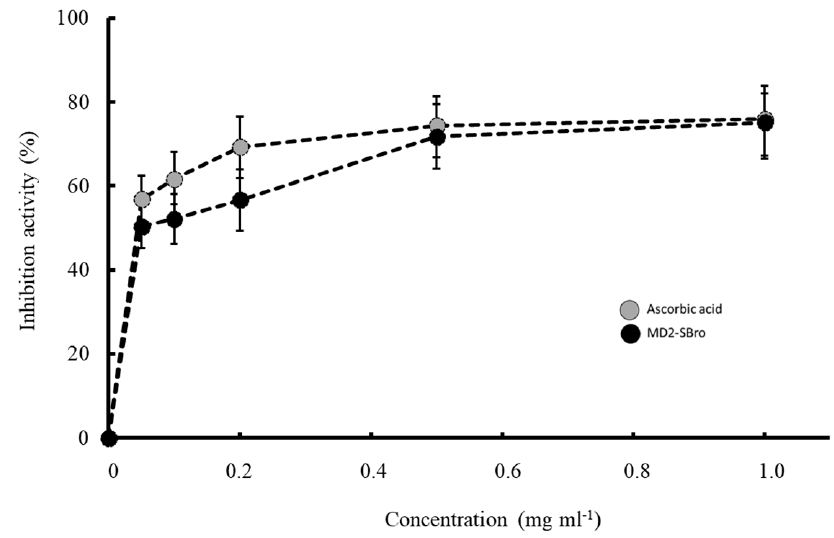
Figure 7. Inhibition of DPPH radical in the presence of different concentrations of ascorbic acid (control) and MD2-SBro.